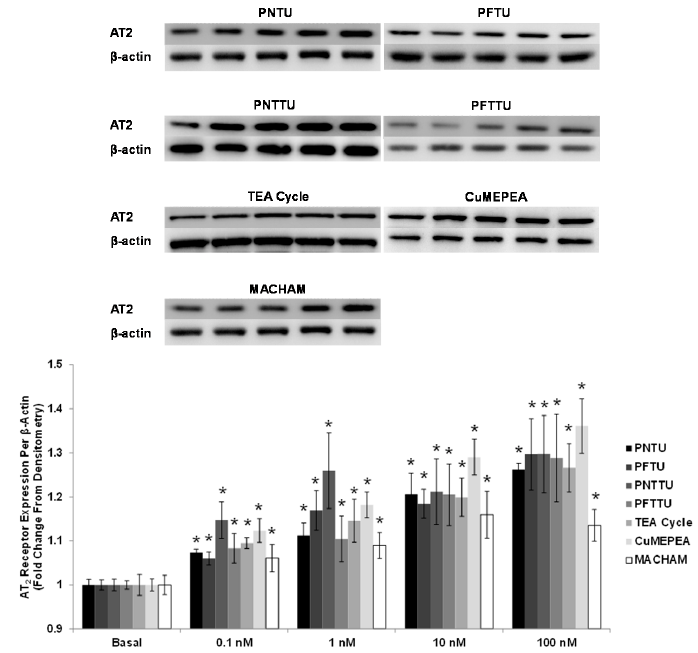
Figure 5. CTB cells were treated with different concentrations of SRs, and Angiotensin II receptor, type 2 (AT 2 ) receptor expression was measured in the cell lysates by Western Blot. The SRs significantly (* p < 0.05) upregulated the expression of AT 2 receptor in CTB cells. The data are presented as mean ± SEM for four experiments. One blot from each of the seven SRs is